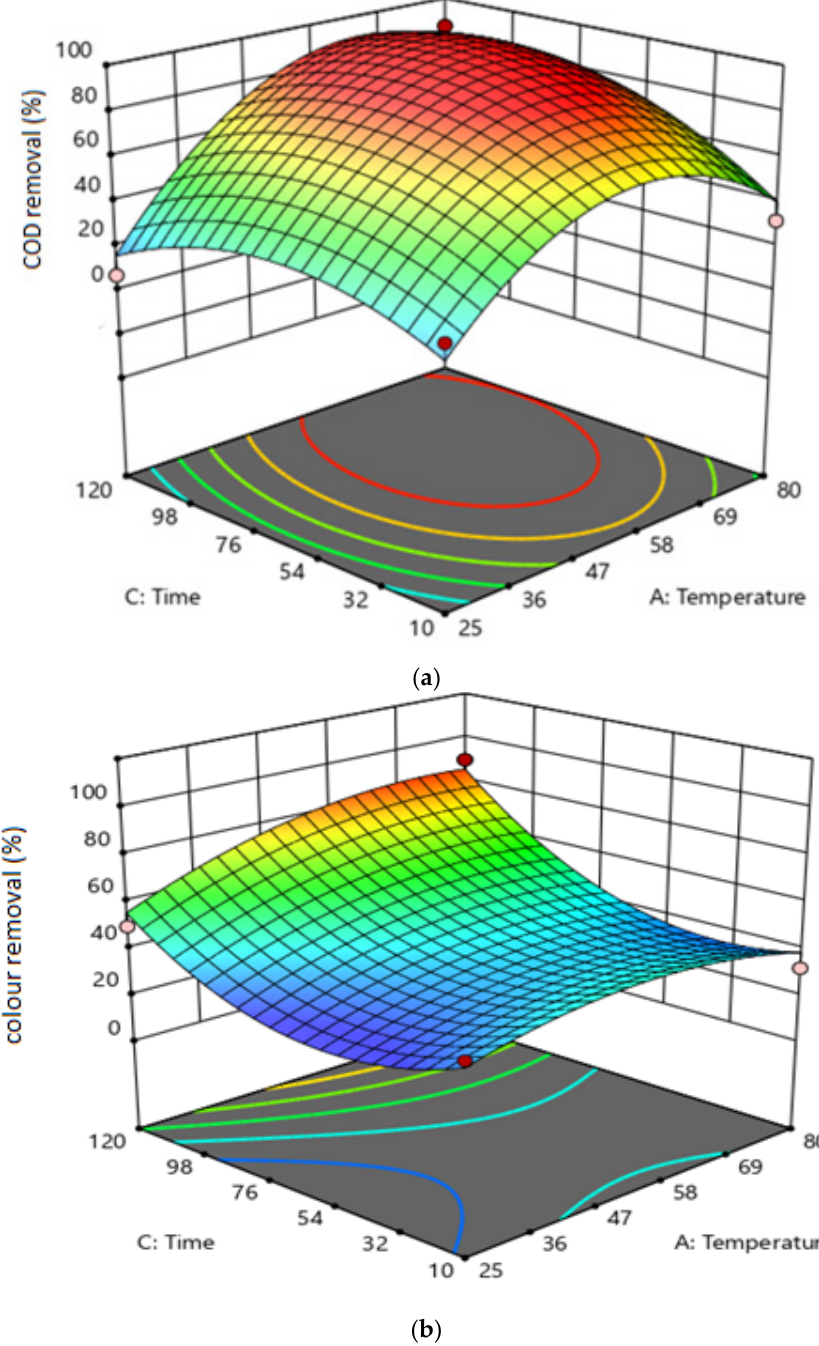
Figure 3. The 3D response surface plots showing the effect of temperature vs. time on ( a ) color removal and ( b ) COD removal (S 2 O 82 − /COD Ratio: 10.00).